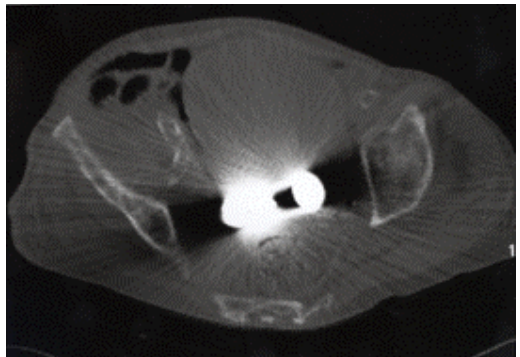
Figure 2. Computed tomography scans of the pelvis revealing the close proximity between the intrapelvically intruded prosthetic stem and the bladder (axial